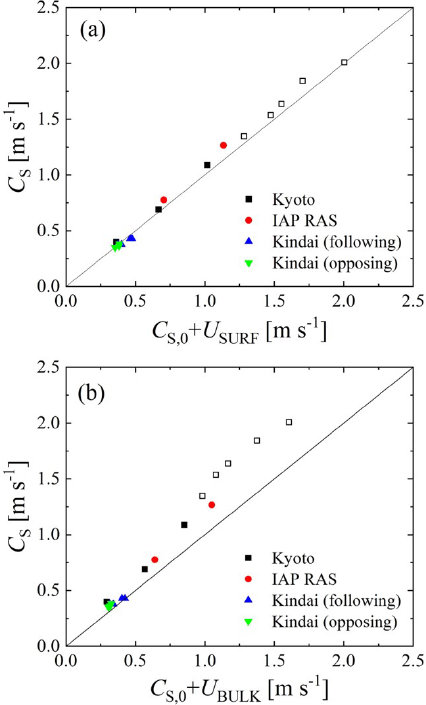
Figure 6. Relationship between phase velocity C S and (a) the sum of C S , 0 and the surface velocity of water U SURF , as well as (b) the sum of C S , 0 and the bulk velocity of water U BULK . Open symbols show the high-wind-speed